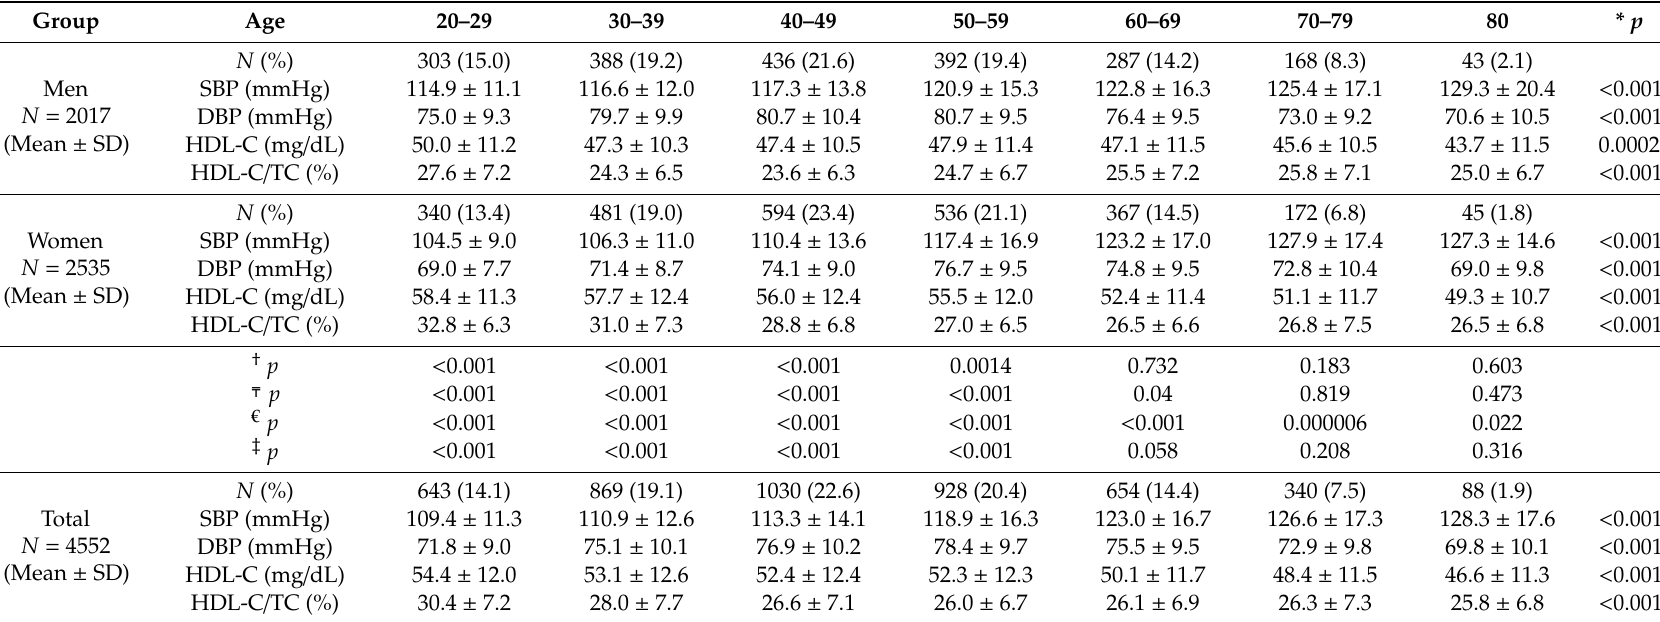
Table 3. Distribution of SBP, DBP, HDL-C, HDL-C / TC (%) depends on age from Korean national health and nutrition examination survey 2017. Table 2. Distribution of SBP, DBP, age and HDL-C in men and women from Korean national health and nutrition examination survey 2017. Group Group Men